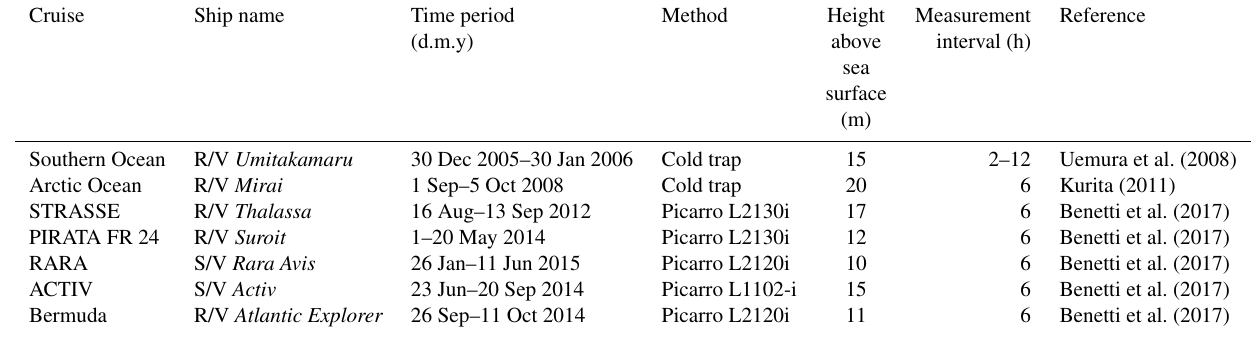
Table 3. Source of data sets used for validation of the IMBL model.